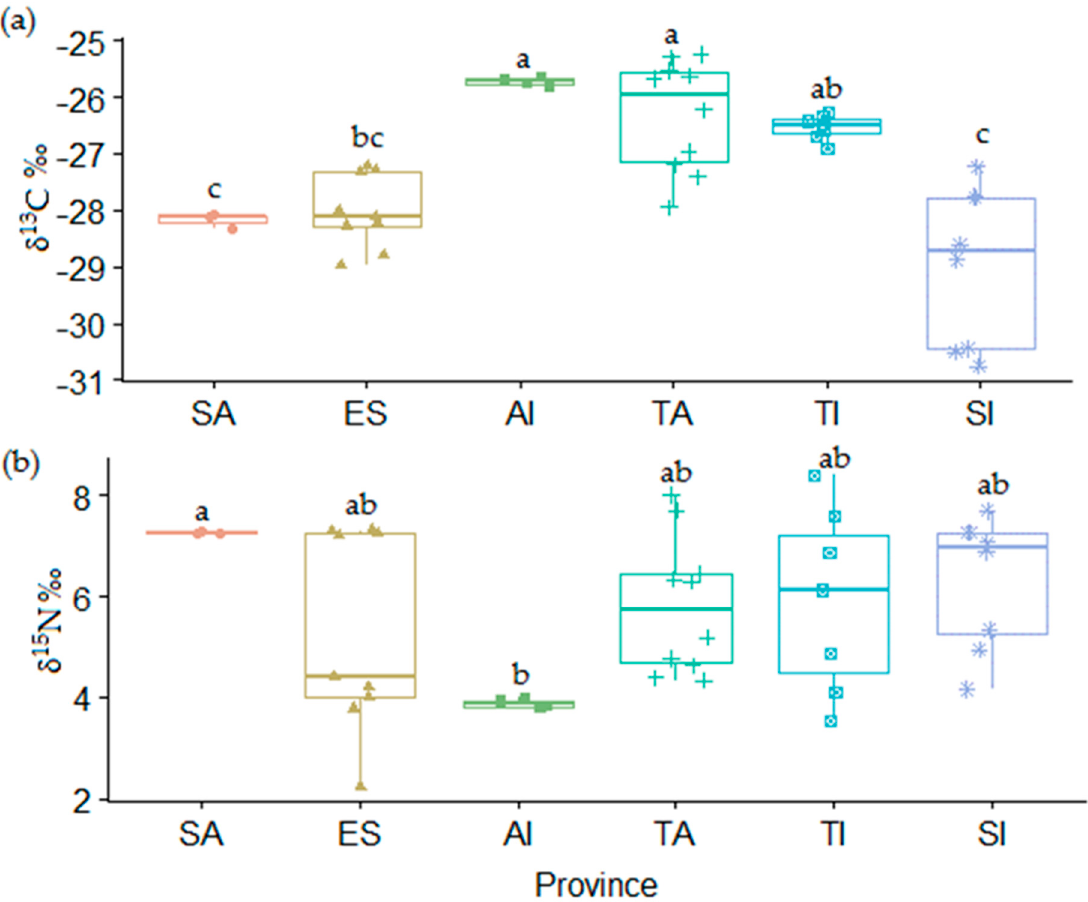
Figure 4. Boxplot of ( a ) δ 13 C and ( b ) δ 15 N in Argan oil samples collected in different provinces (Safi (SA), Agadir Ida Outanane (Ai), Essaouira (ES), Sidi Ifni (SI), Taroudant (TA) and Tiznit (TI). Significant differences ( p < 0.05) were expressed by different letters.